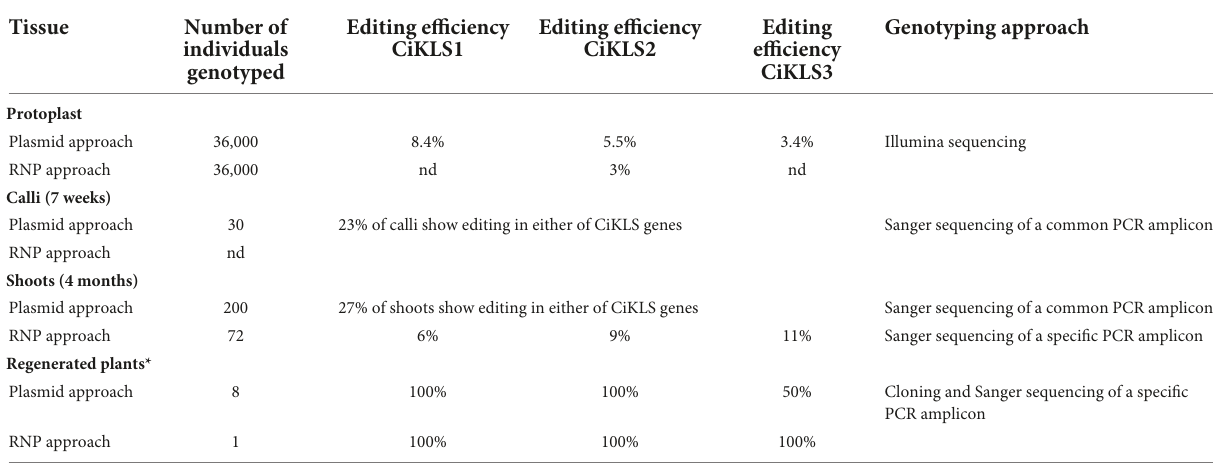
TABLE 1 Summary of genotyping results of the gene edited chicory